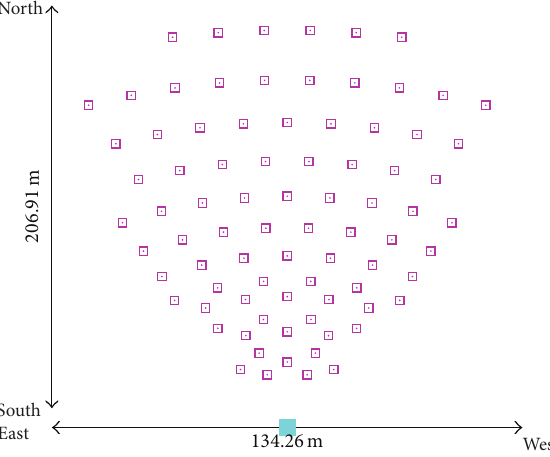
Figure 4: Layout of the heliostat field. The receiver, located at the north face of the tower, is centered at (0, 0,